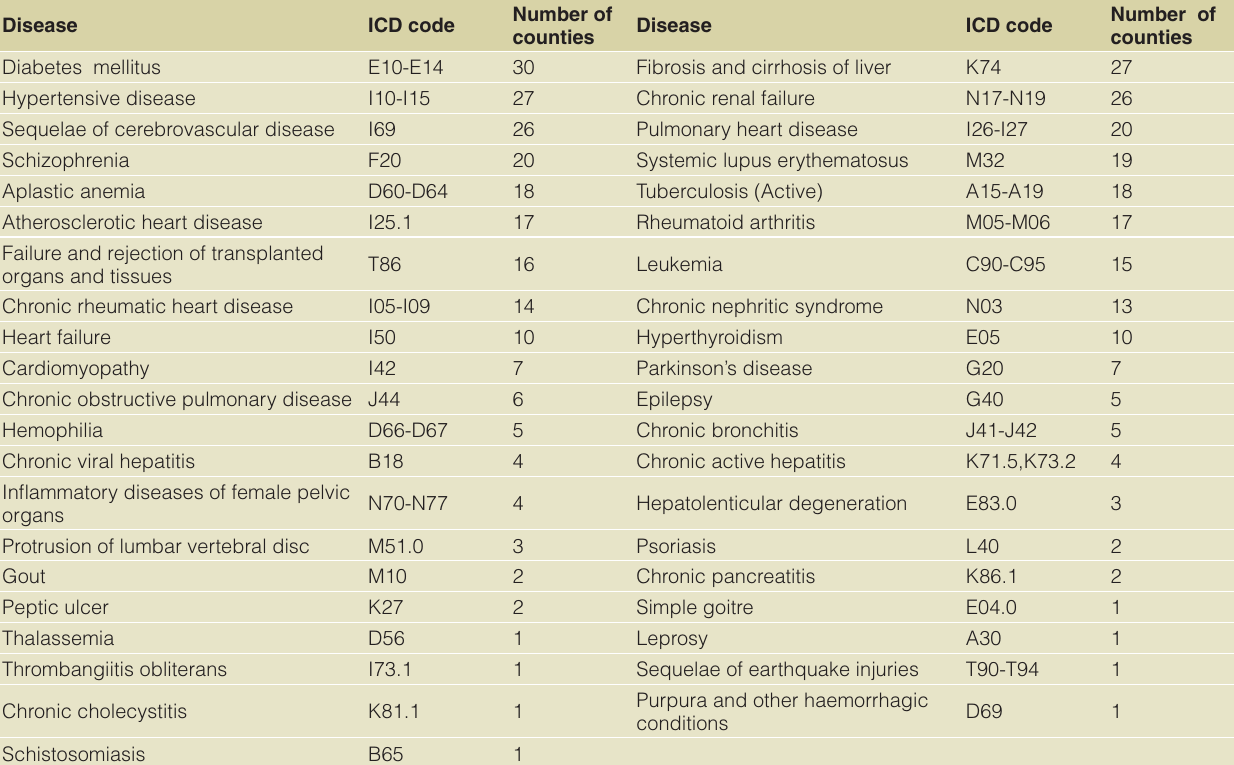
Table 2. Selection of chronic diseases, ICD code and positive listing for reimbursement in 32 counties.